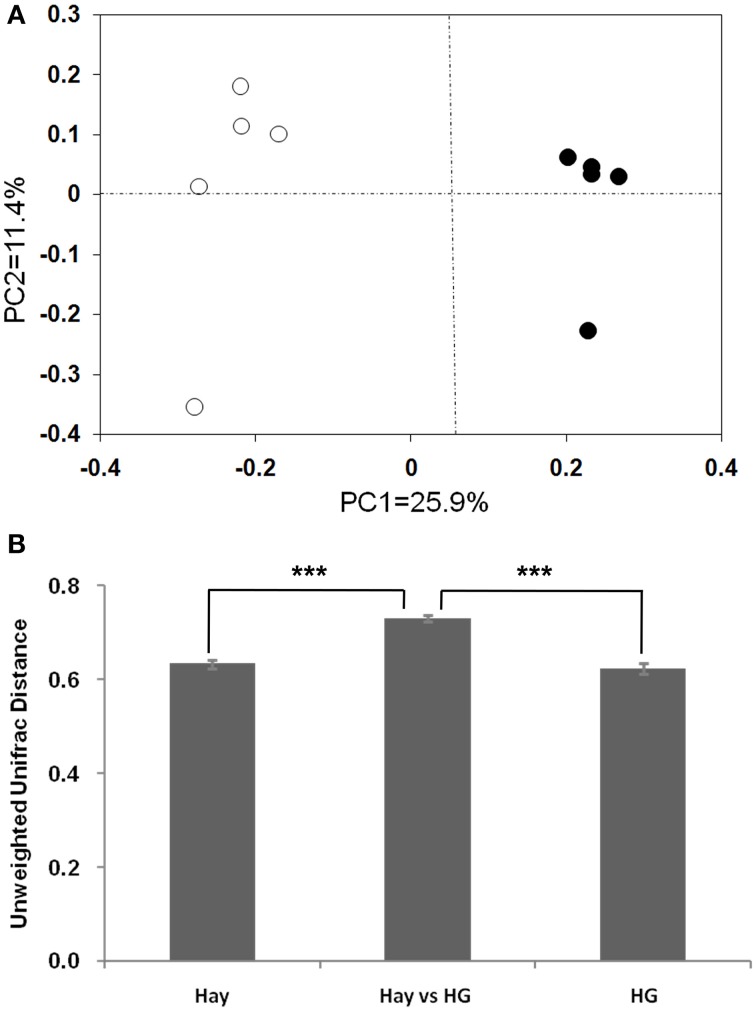
Differences in the ruminal epithelial (epimural) bacterial structure between hay and high-grain (HG)-fed goats. (A) Unweighted UniFrac principal coordinate analysis (PCoA) of epimural microbiota based on the operational taxonomic unit data from 454 pyrosequencing run. The marks relate to the diets of donor goats: hay diet (°), HG diet (•). (B) Mean pairwise unweighted UniFrac distance for subsets of samples (means ± SEM, n = 5). Hay, sample-to-sample variation among replicates in hay group; HG, sample-to-sample variation among replicates in HG group; Hay vs. HG, hay vs. HG comparison variation. ***P < 0.001.